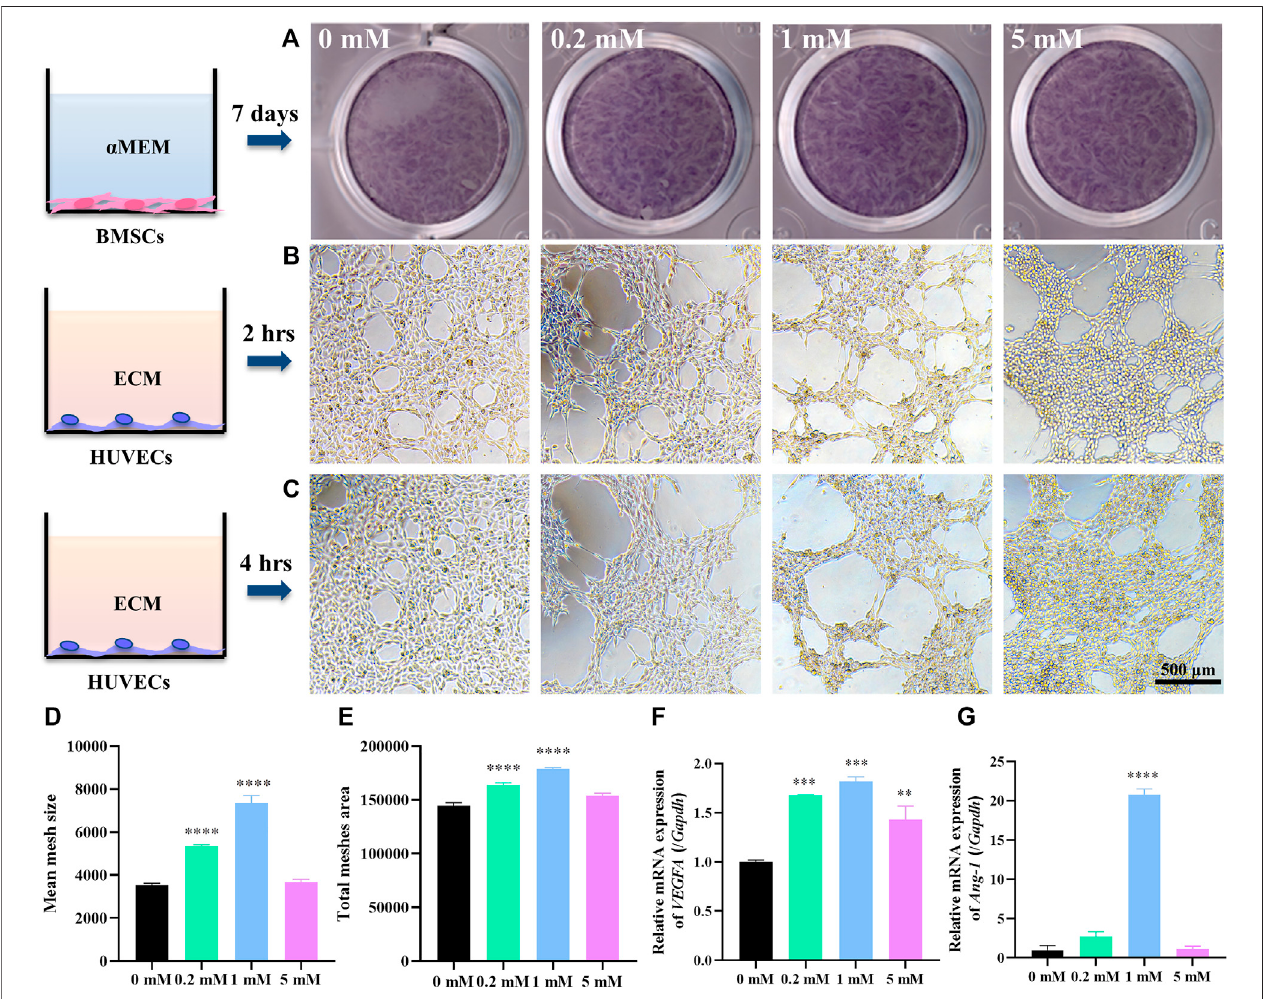
FIGURE 1 | Sr stimulates the osteogenic ability of hBMSCs and angiogenic ability of HUVECs in vitro . (A) ALP staining of hBMSCs cultured in α -MEM with Sr at 0, 0.2,1,and5 mMfor7 days. (B,C) TubeformationassayofHUVECsculturedinECMwithSrCl 2 at0,0.2,1,and5 mMfor2 h (B) and4 h (C) withquantitativeanalysisby ImageJof (D) meansizeofmeshesand (E) totalmeshareaattimepoint “ 2 h ” . (F) RelativeexpressionofVEGFAgeneinHUVECsculturedfor3 daysand (G) Ang-1gene for 7 days in ECM with Sr at 0, 0.2, 1, and 5 mM ( n = 3, * p < 0.05, ** p < 0.01, *** p < 0.001, **** p < 0.0001, compared with the 0 mM